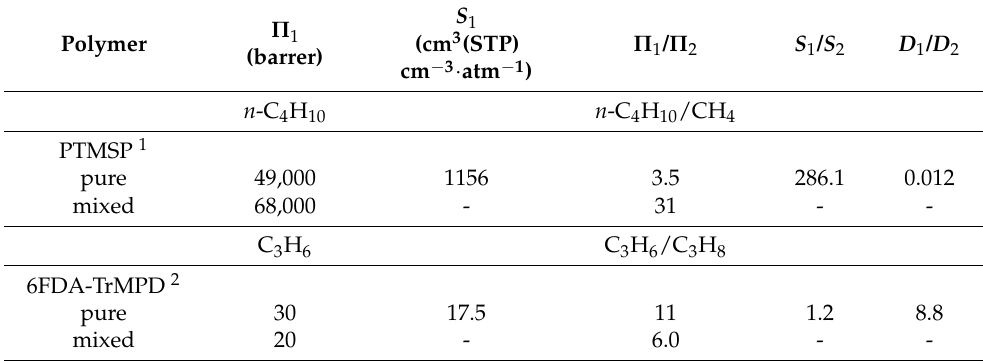
Table 1. Permeabilities and solubility coefficients (Henry’s constants), and their ratio for n - C 4 H 10 /CH 4 (2 mol %/98 mol %) and C 3 H 6 /C 3 H 8 (equimolar mixture) in PTMSP and 6FDA-TrMPD membranes, respectively. Diffusivity selectivities are shown in the last